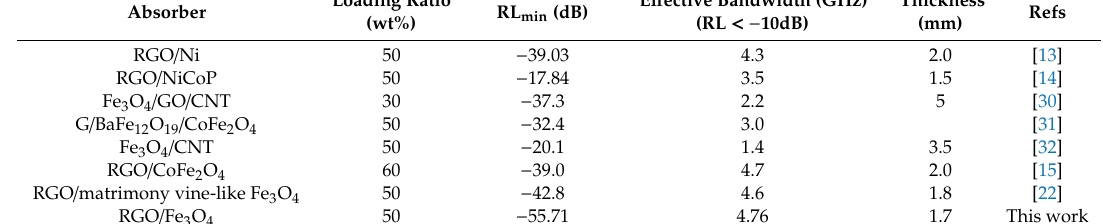
Table 1. Comparison of microwave absorption properties in this work and other representative works.